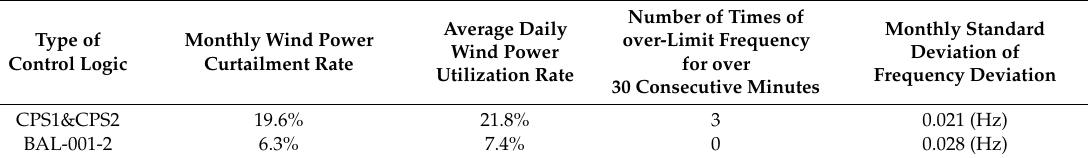
Table 4. Control actions under different conditions.